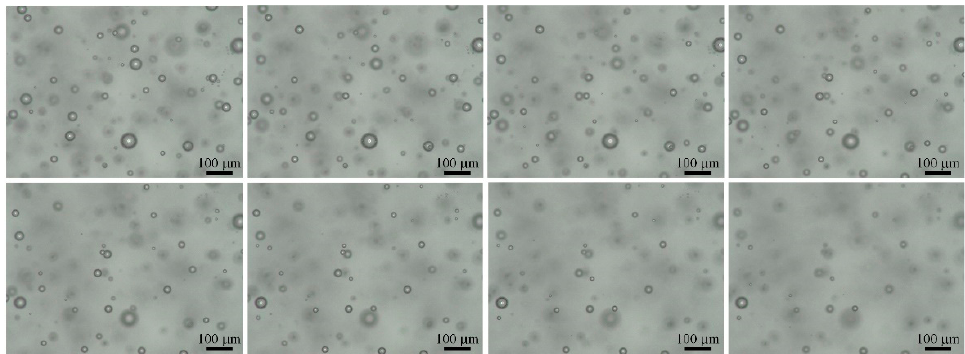
Figure 3. Bubble image change in continuous frames.